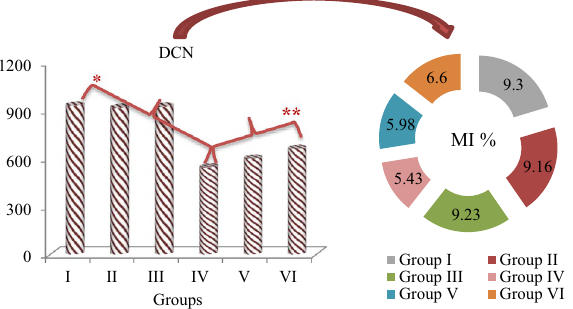
Figure 3. GSE and KBrO 3 effects on dividing cell number (DCN) and MI in A. cepa root tip cells. Group I: Control, Group II: 465 mg/L GSE, Group III: 930 mg/L GSE, Group IV: 100 mg/L KBrO 3 , Group V: 100 mg/L KBrO 3 + 465 mg/L GSE, Group VI: 100 mg/L KBrO 3 + 930 mg/L GSE. *indicates the statistical difference between Groups I and IV, **indicates a statistical difference between Groups IV and VI (p < 0.05). MI rate was calculated by analyzing 10.000 cells in each group.